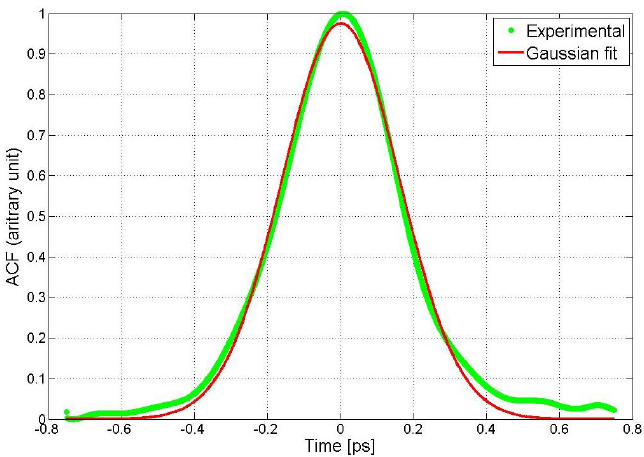
Figure 6. Cross-correlation measure and its Gaussian fit.